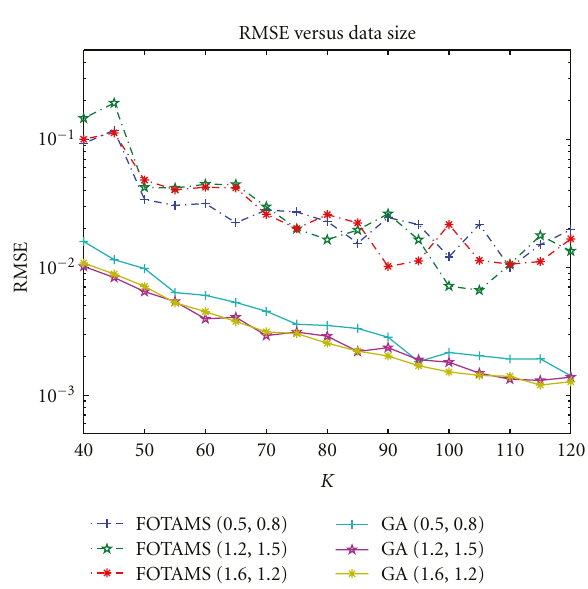
Figure 6: RMSEs of frequency estimation versus the data size, e ( m , n ) is i.i.d white exponential noise, SNR = 0dB.